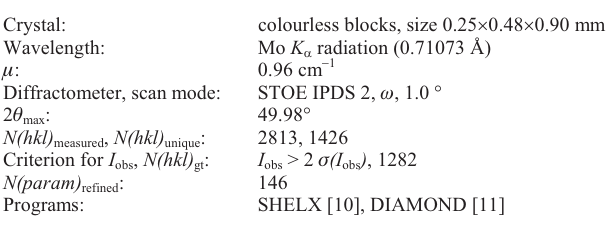
Table 1. Data collection and handling.